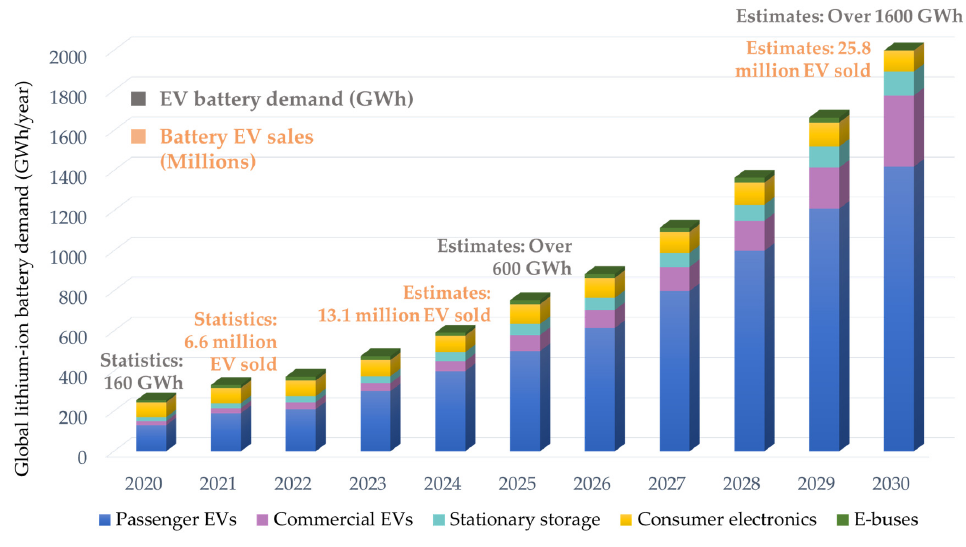
Figure 1. Global lithium-ion battery demand and